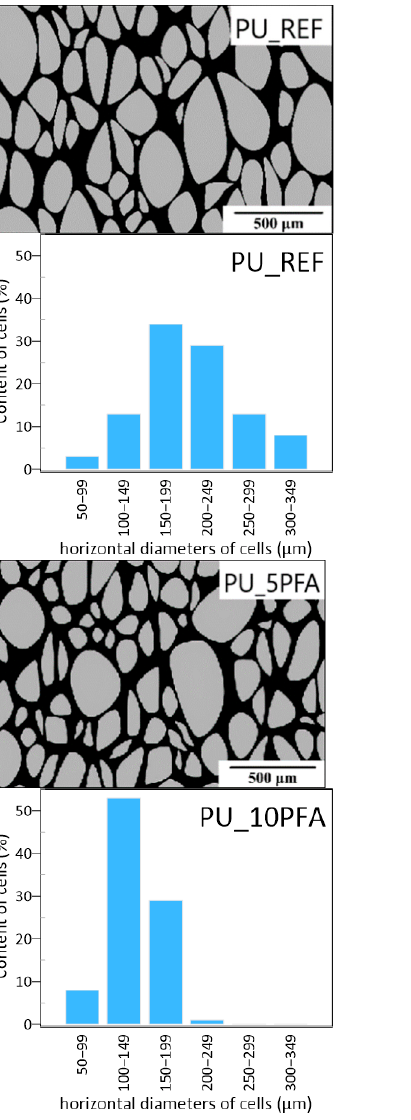
Figure 5. Morphologies and cell diameters of RPUFs.